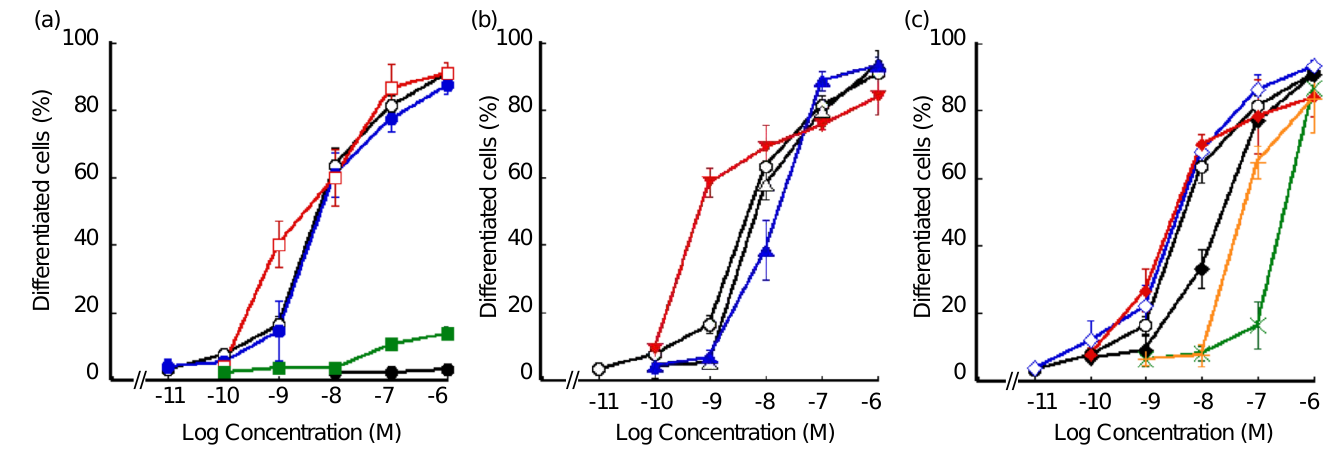
Figure 3. HL-60 cell differentiation-inducing activity of lithocholic acid amide derivatives. Differen- tiated cells were determined by measuring the ratio of nitroblue tetrazolium (NBT)-positive cells.